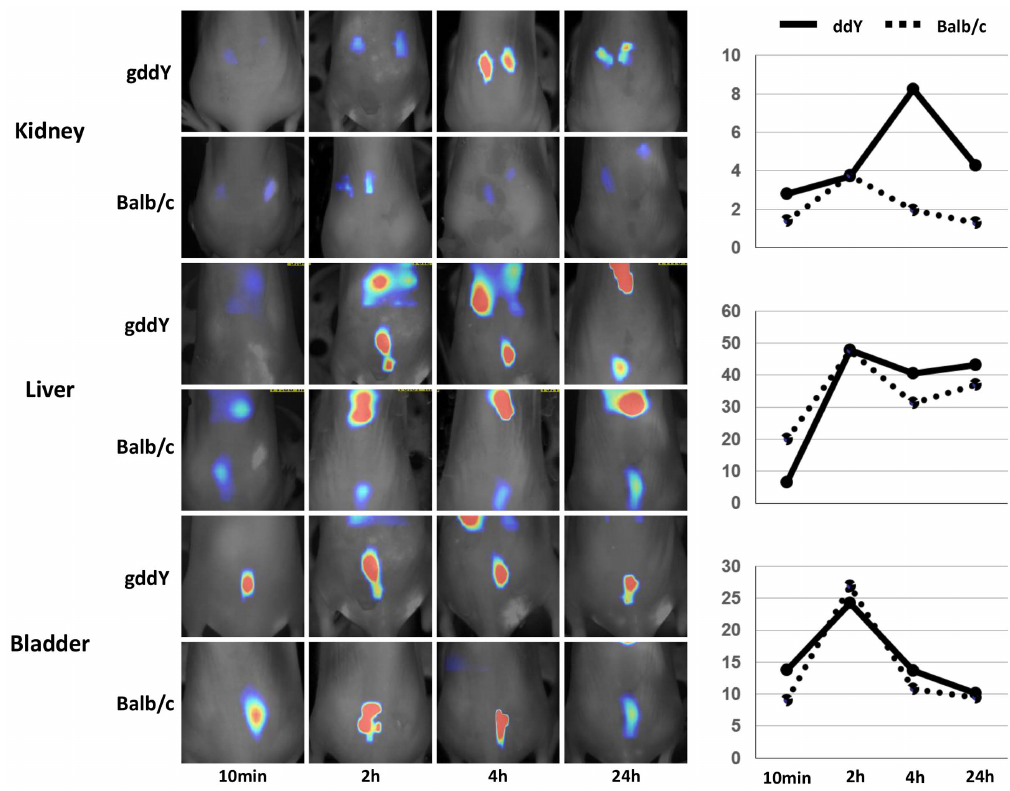
Figure 2. Kinetics of injected fluorescently labeled IgA in a fluorescence molecular tomography system. A fluorescence molecular tomography system (FMT) is capable of resolving size and concentration of fluorochromes in deep tissue in vivo . Fluorescein-labeled IgA samples from gddY and Balb/c mice were injected into nude mice and monitored from 10 min to 24 h postinjection by FMT. After 2 h, IgA signals in the liver and bladder were found in a similar manner in both the groups of nude mice. However, IgA signals in the kidneys clearly differed between them. Mice injected with gddY IgA showed strong signals in the kidneys, with a peak at 4 h.